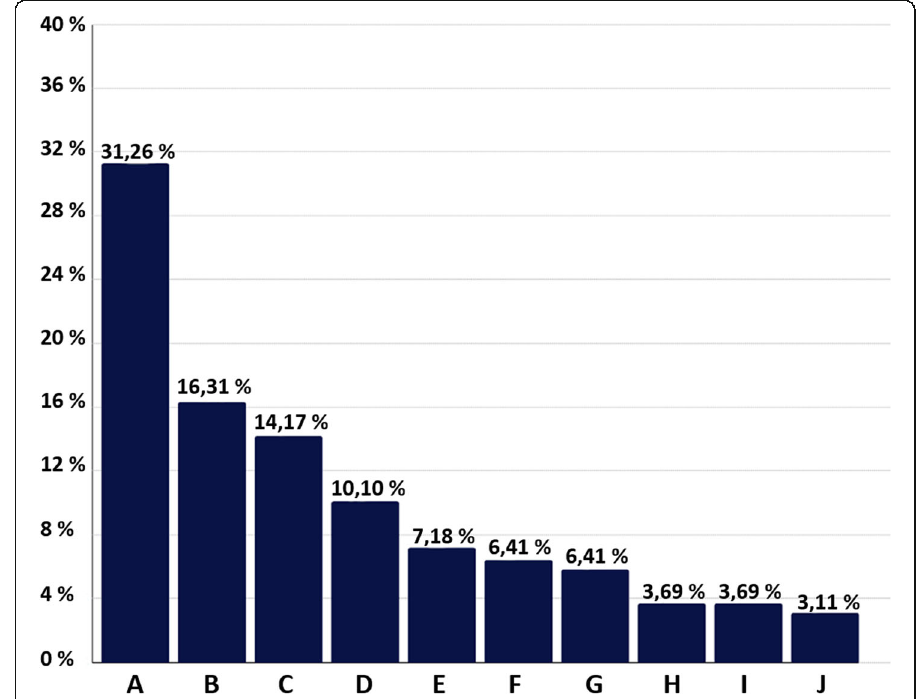
Fig. 4 Coverage percentage of the created definition according to codes. A . Combination of physical and virtual environments; B Ergonomic or inclusive experience; C Physical environment enriched with technology; D Learning alternatives or paths; E Smart education or pedagogies; F Educational